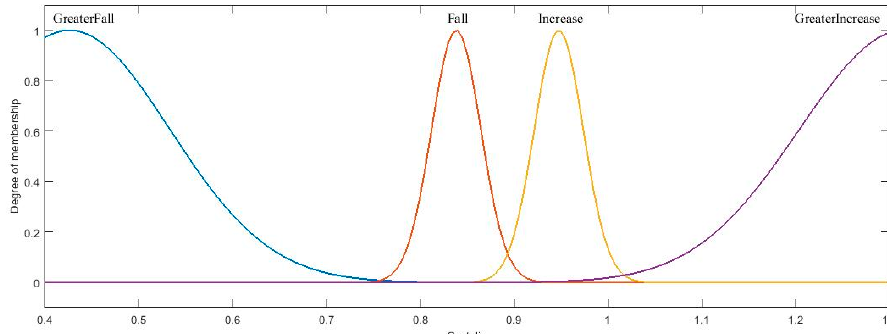
Figure 22. Optimized diastolic quotient input.